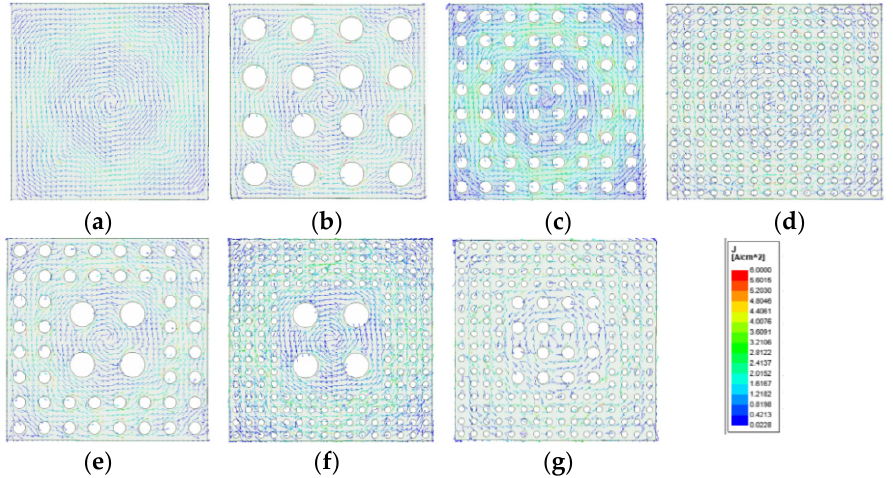
Figure 12. Eddy current vector distribution on an aluminium plat: ( a ) Solid aluminium plate; ( b ) Aluminium plate with 4 × 4 mesh, ( c ) Aluminium plate with 8 × 8 mesh, ( d ) Aluminium plate with 16 × 16 mesh, ( e ) Center 4 × 4 edge 8 × 8 mesh, ( f ) Center 4 × 4 edge 16 × 16 mesh, ( g ) Center 8 × 8 edge 16 × 16